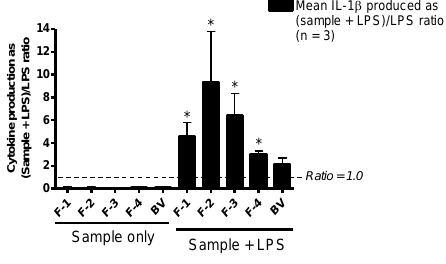
Figure 5. Effect of bee venom and its fractions of IL-1 β /IL-1F2 production in PMA-differentiated U937 cells. All five been venom (BV) fractions tested produced only background levels of IL-1 β /IL-1F2 when used alone. In the presence of LPS, there was significant synergy, especially with F-2 and F-3, which resulted in a nine- and six-fold increase in the production of the cytokine, respectively. Significant synergy was also observed with F-1 (four-fold) and F-4 (three-fold), but not with BV despite a two-fold increase in the latter ( n = 3).